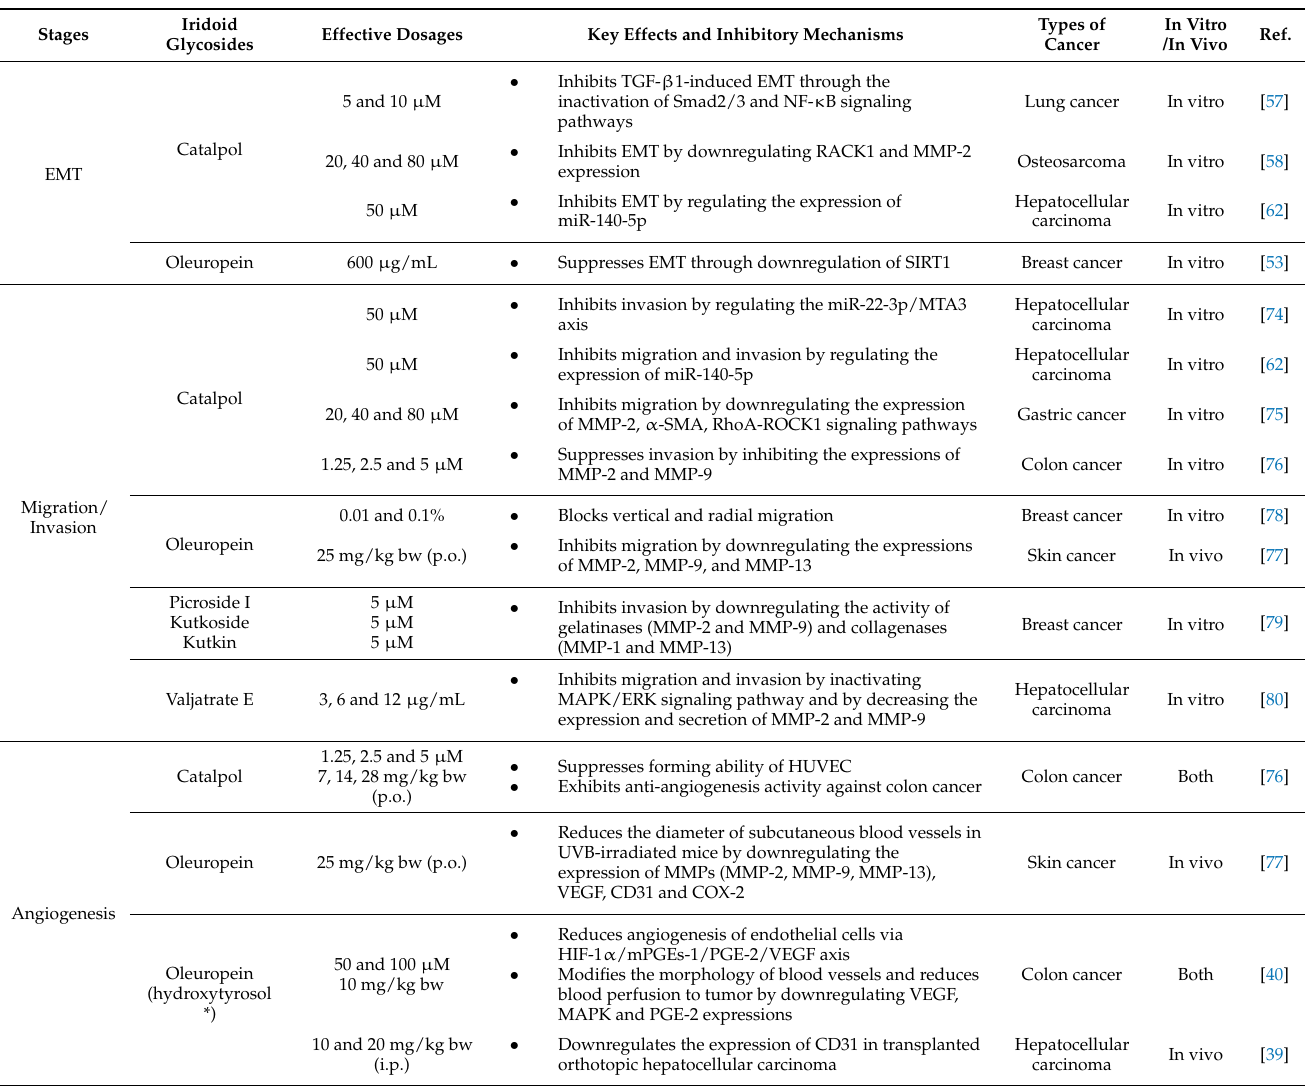
Table 1. Cont. Key Effects and Inhibitory